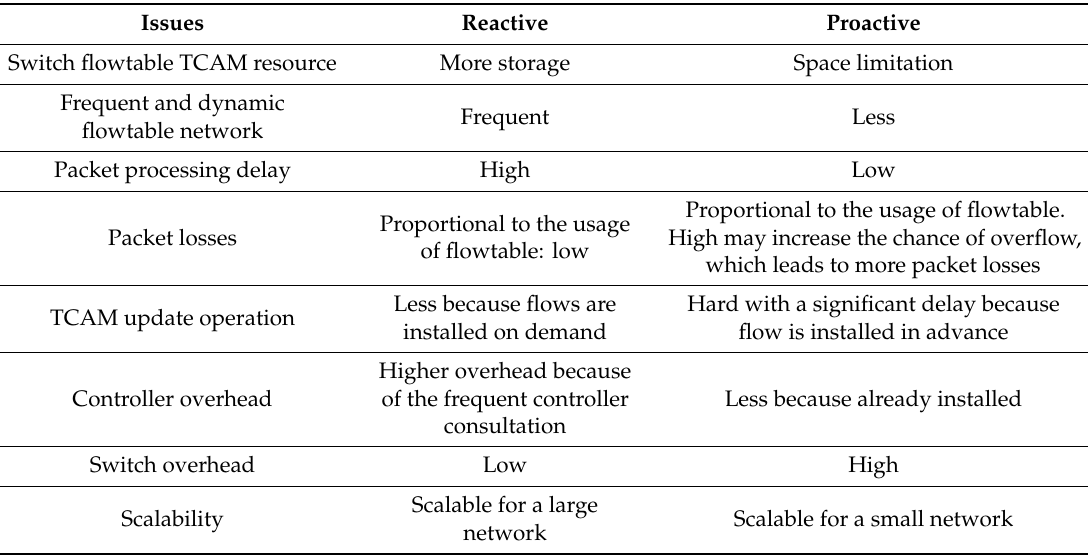
Table 6. Reactive and proactive rule allocation